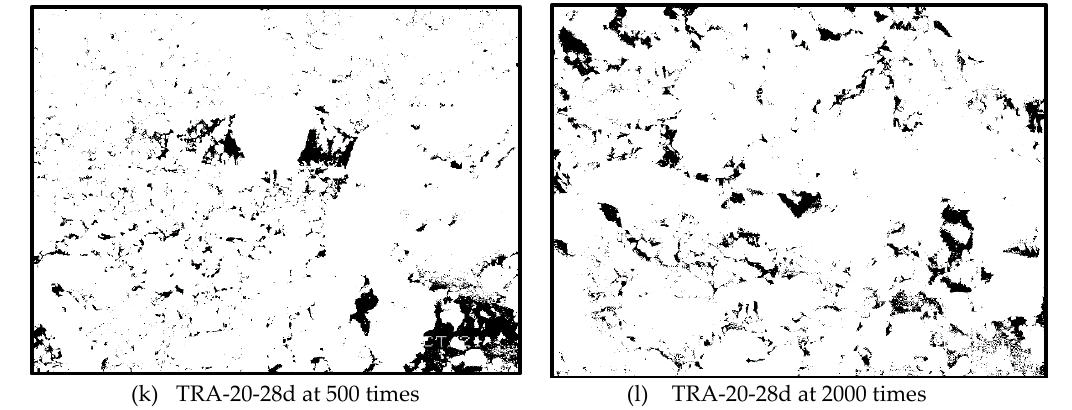
Figure 9. Black and white binary images of RA, SRA, and TRA samples: ( a ) RA-20-7d at 500 times; ( b ) RA-20-7d at 2000 times; ( c ) SRA-20-7d at 500 times; ( d ) SRA-20-7d at 2000 times; ( e ) TRA-20-7d at 500 times; ( f )TRA-20-7d at 2000 times; ( g ) RA-20-28d at 500 times; ( h )RA-20-28d at 2000 times; ( i ) SRA-20-28d at 500 times; ( j ) SRA-20-28d at 2000 times; ( k ) TRA-20-28d at 500 times; (l) TRA-20-28d at 2000 times. Table 8. Porosity of RA, SRA, and TRA samples/%.